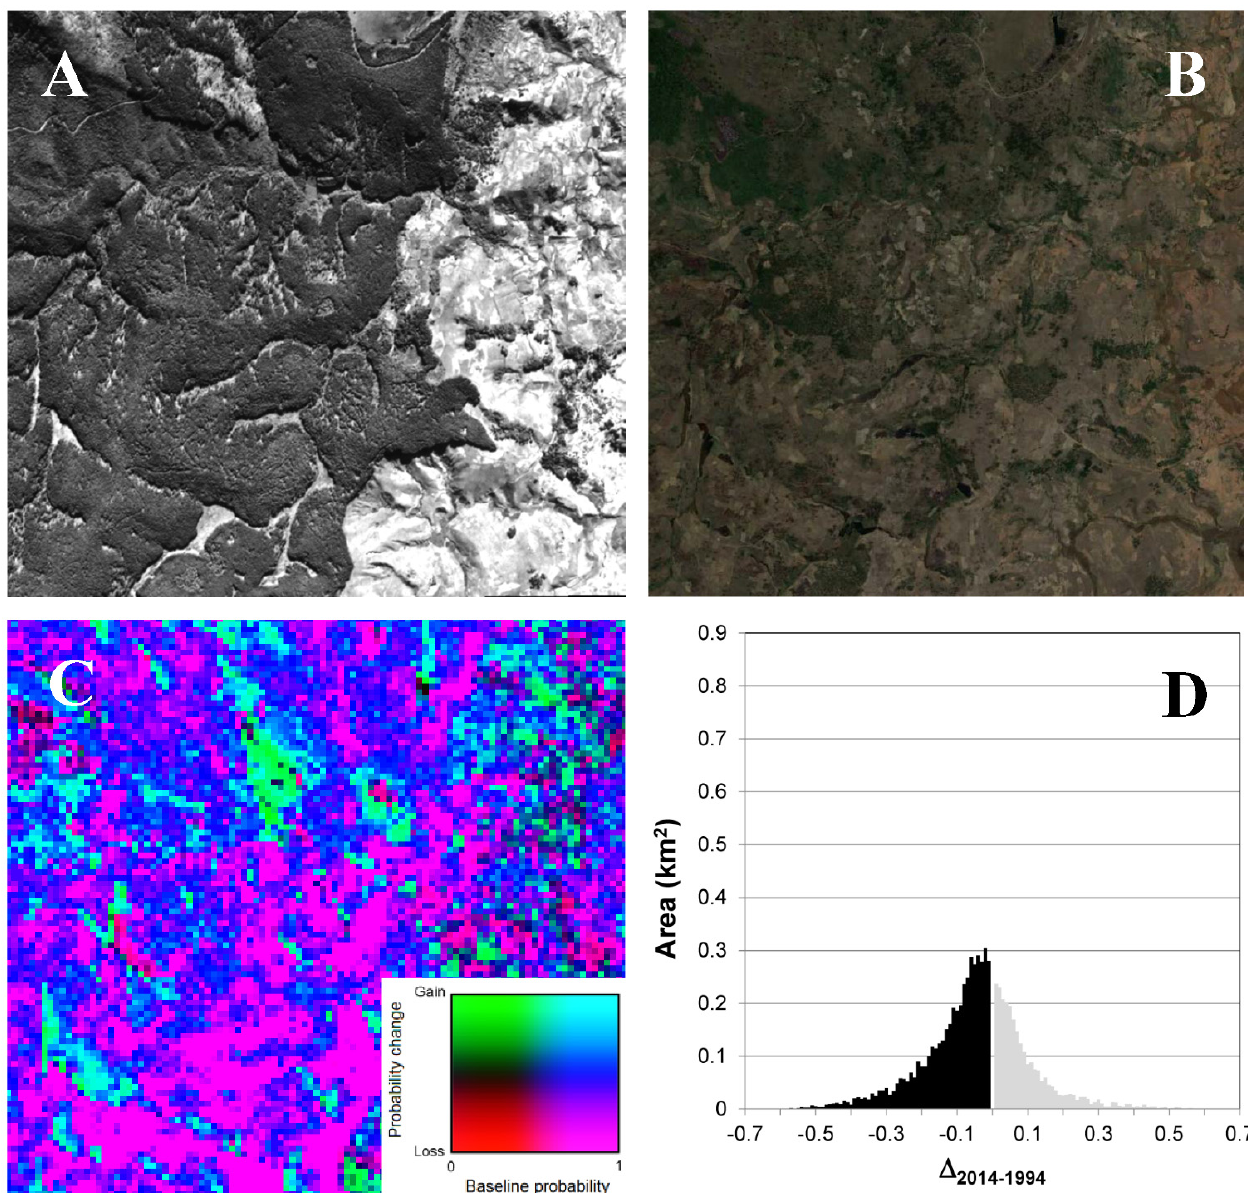
Figure 4. Dynamics of woody cover at Site 02, Ambozontany, south of Fianaratsoa (21°48'S, 47°6'E). ( A ) Aerial photograph taken in 1991. ( B ) Digital Globe image taken in 2014. ( C ) Change map based on Landsat imagery (see Figure 2). ( D ) Histogram